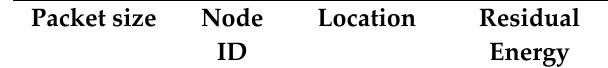
Figure 6. Format of data packet type_2.